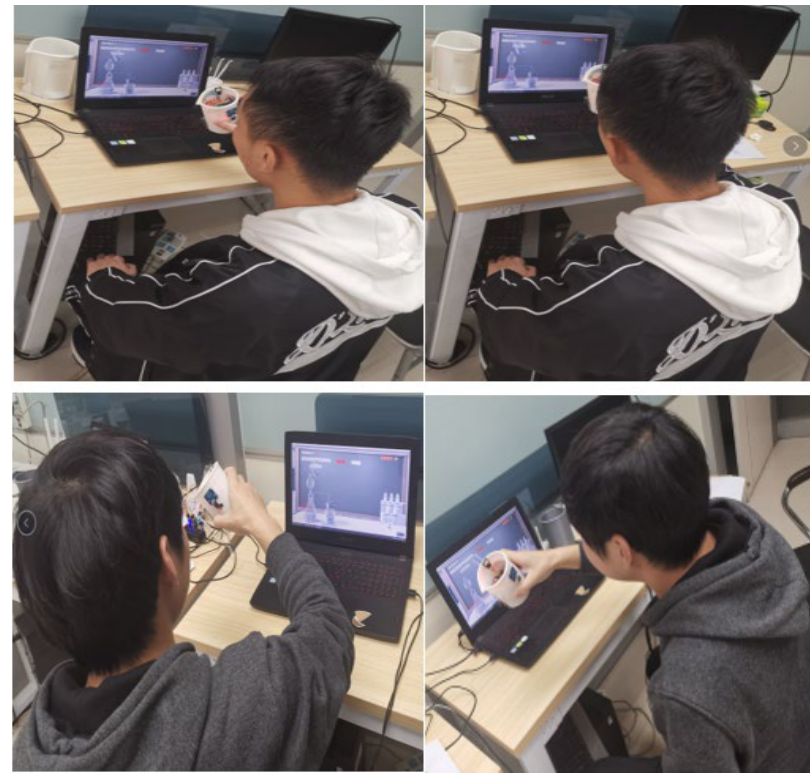
Figure 19. Students conducting experiments.